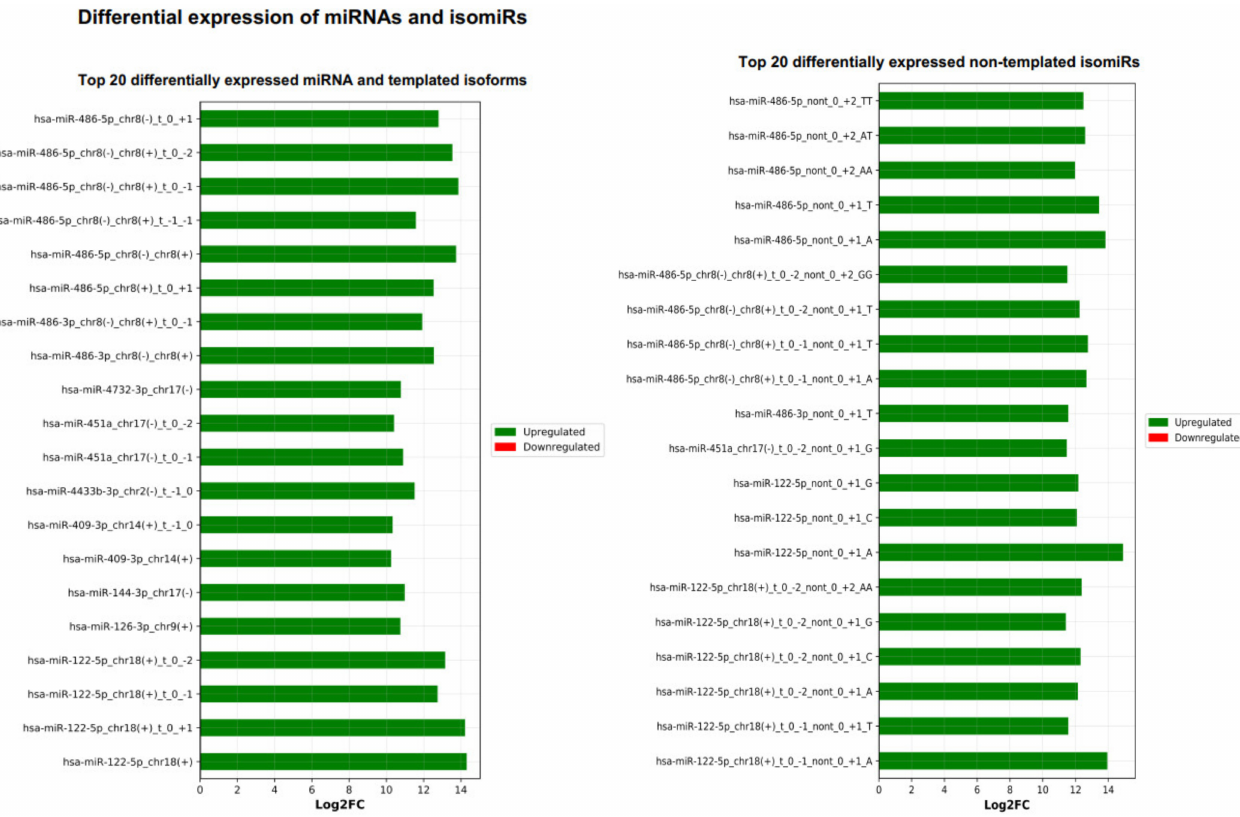
Figure 8. Top 20 differentially expressed miRs and isomiRs (template and non-template) generated by miRViz